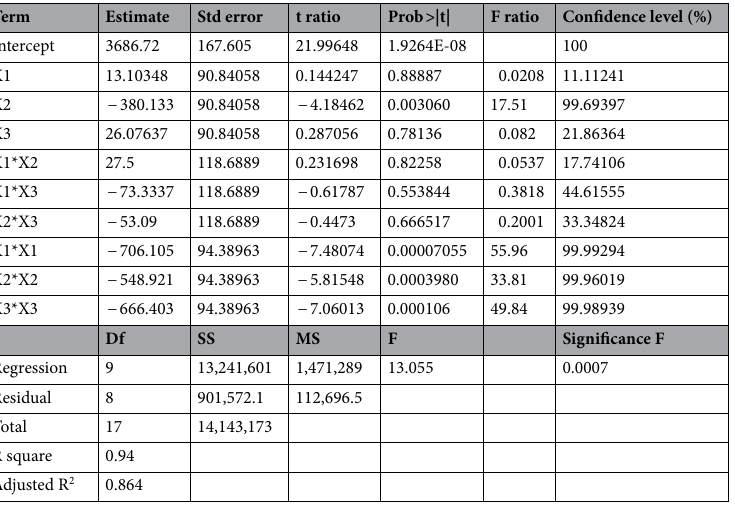
Table 4. Statistical analysis of the RCCD showing coefficient values and t- and p- values for each variable on ALP